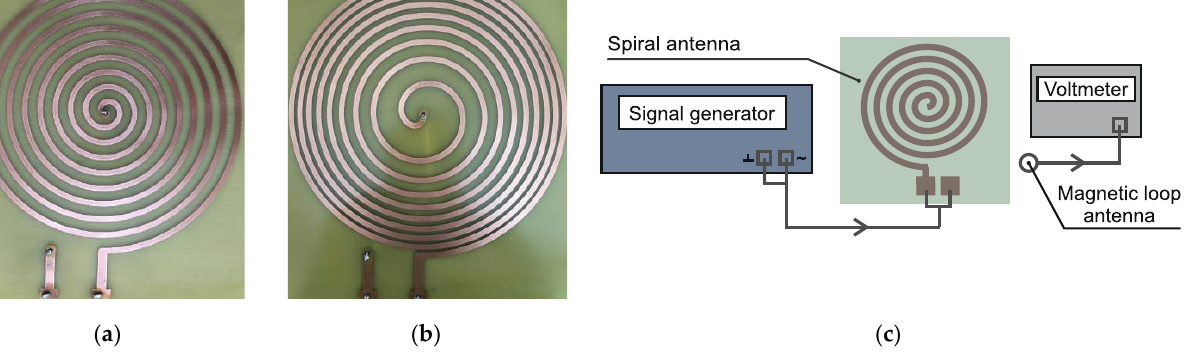
Figure 8. Experimental studies: ( a ) model of the antenna in the form of an Archimedean spiral; ( b ) layout of the modified antenna; ( c ) equivalent scheme of the experimental setup.